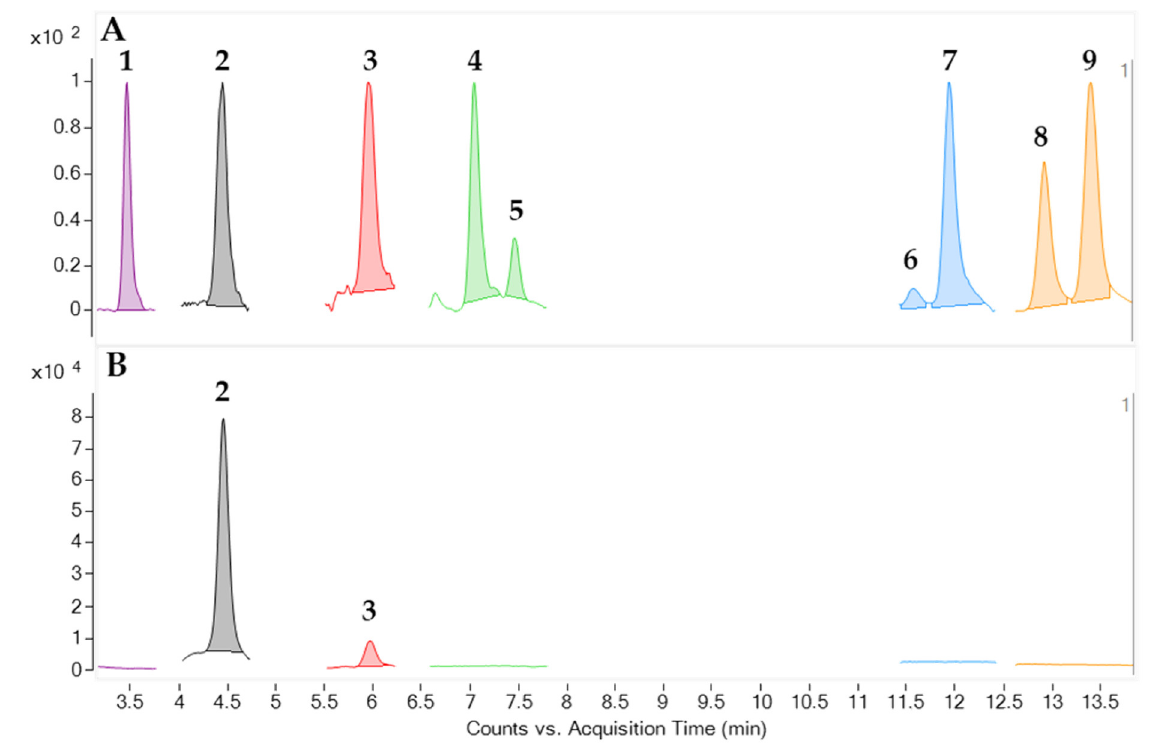
Figure 6. LC-MS/MS chromatogram of: ( A ) Reference materials of CTXs: CTX1B (1) ( m/z 1133.6 -> m/z 1133.6), C-CTX1 (2) ( m/z 1163.7 -> m/z 1163.7), C-CTX1-Me (3) ( m/z 1177.6 -> m/z 1177.6), 52-epi-54-deoxyCTX1B/54-deoxyCTX1B (4 & 5) ( m/z 1117.6 -> m/z 1117.6), 49-epiCTX3C/CTX3C (6 & 7) ( m/z 1045.6 -> m/z 1045.6), CTX4A/CTX4B (8 & 9) ( m/z 1083.6 -> m/z 1083.6); ( B ) C-CTX1 (2) (56.9 ng/mL) and traces of C-CTX1-Me (3) detected in the reference material.